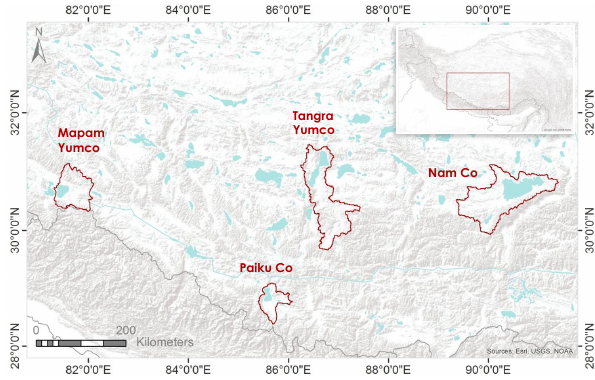
Figure 1. Location of the study region comprising four selected endorheic lake